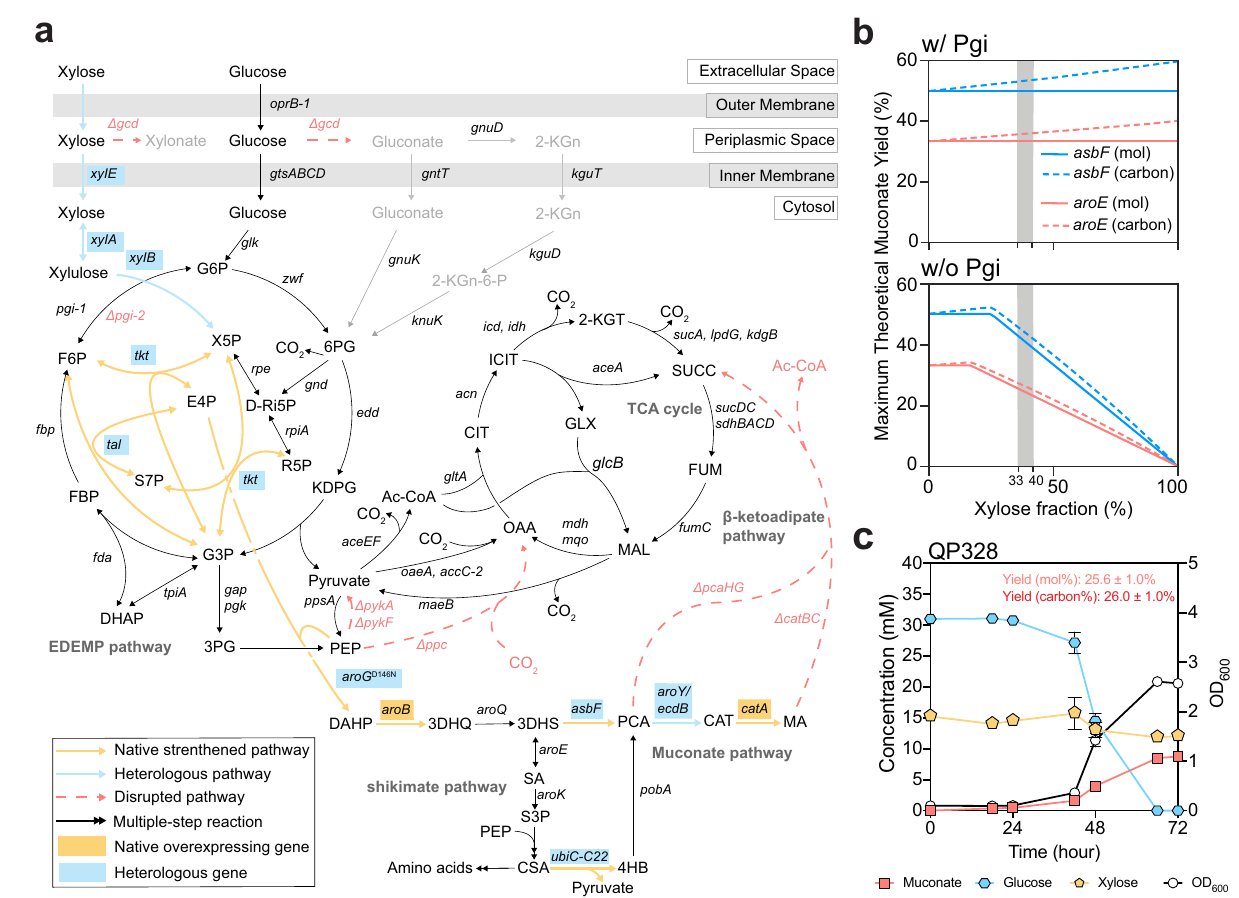
Fig. 1 | Muconate production from glucose and xylose. a Schematic of the overall metabolic engineering strategy. To utilize xylose, xylE , D -xylose isomerase ( xylA ), xylulokinase ( xylB ), transaldolase ( tal ), and transketolase ( tkt ) from E. coli were heterologously expressed. E4P and PEP were condensed to form DAHP via a feedback-resistant DAHP synthase ( aroG D146N ) 70 . To convert DAHP to muconate (MA),genesencoding a 3-DHSdehydratase( asbF )from Bacillus cereus , anda PCA decarboxylase ( aroY ) and its corresponding co-factor generating protein ( ecdB ), both from Enterobacter cloacae , were heterologously expressed. aroB and cate- chol 1,2-dioxygenase ( catA ) were overexpressed 3,32 . An engineered chorismate pyruvate-lyasefrom E. coli ( ubiC -C22) 40 was overexpressedto convert chorismate (CSA) to 4-hydroxybenzoate (4HB), which can be converted to PCA and MA. Deleted genes are shown in red. Glucose dehydrogenase ( gcd ) was deleted to preventtheformationofxylonateorgluconate. Glucose-6-phosphate isomerases pgi-1 and pgi-2 were each deleted previously 3,32 , but pgi-1 was restored in this study. Pyruvate kinases pykA and pykF were each deleted to reduce competition for PEP. To accumulate MA, pcaHG and catBC were deleted to prevent ring- opening of PCA and catabolism of MA, respectively. P phosphate, 2-KGn 2-